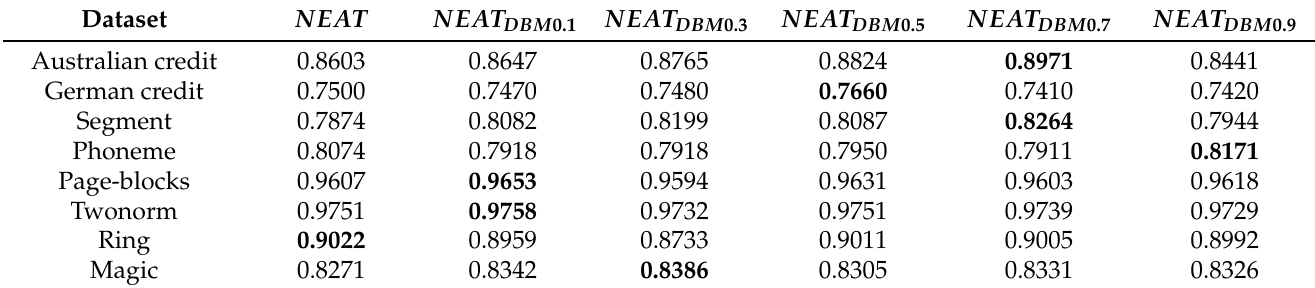
Table 4. Sensitivity analysis of NEAT-DBM compared to NEAT, test set.